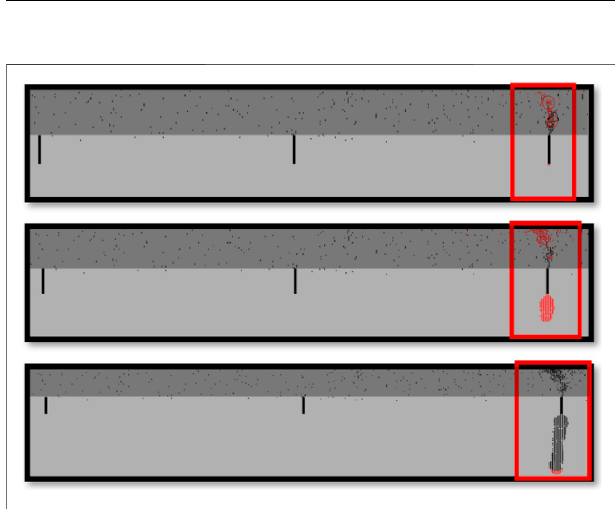
FIGURE 15 | Distribution of AE during formation of re fl ection cracks when S/T =